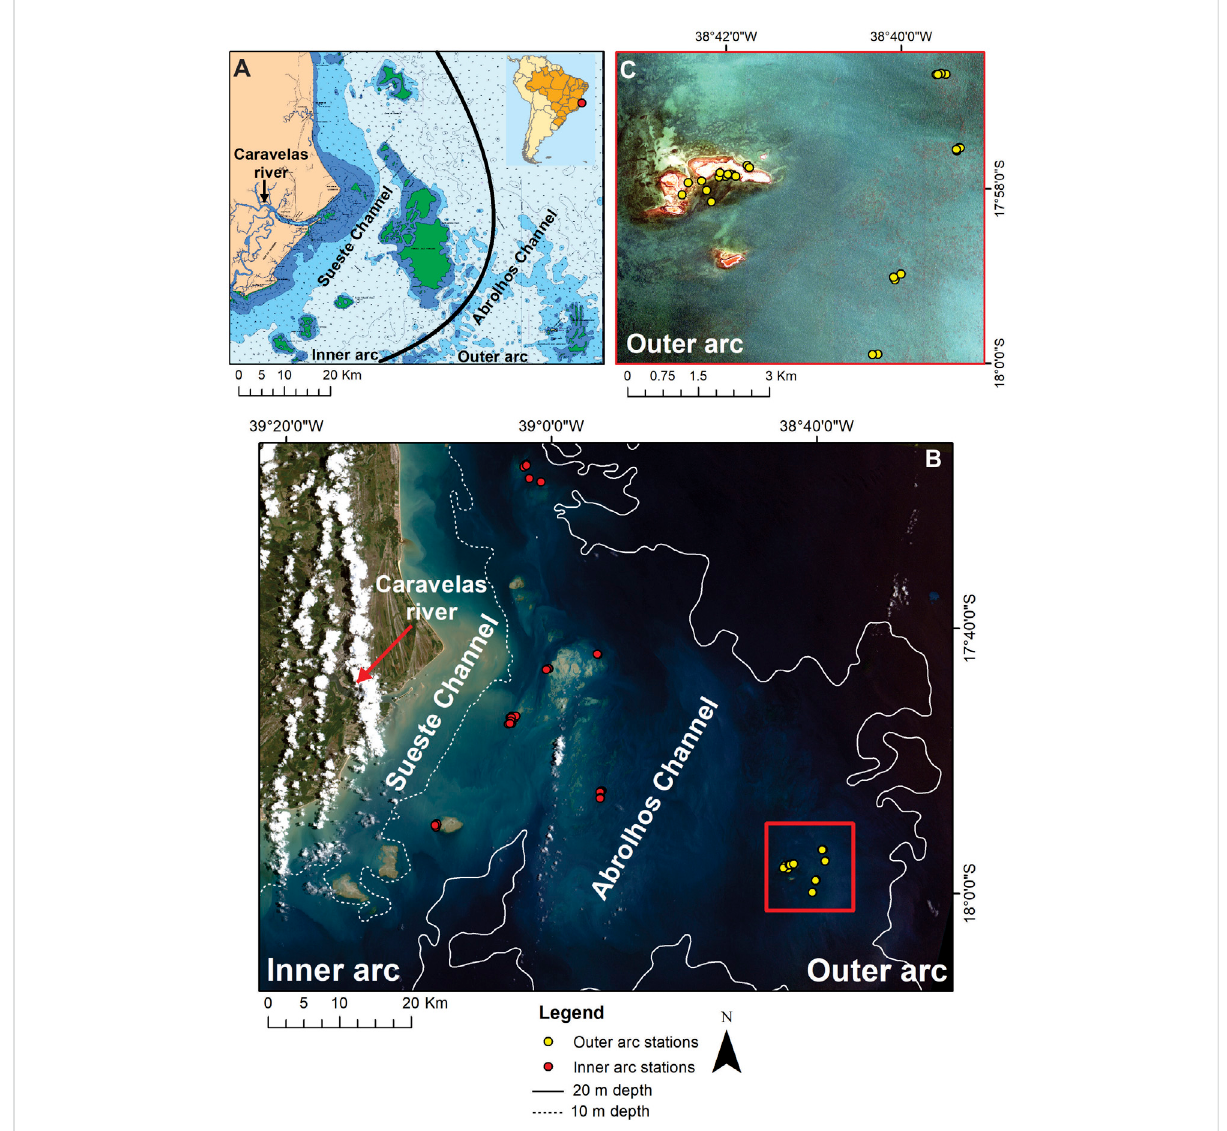
FIGURE 1 Location of the sampling stations in the Abrolhos Bank. (A) General geographical location of the study area, highlighting the Sueste and Abrolhos channels and the inner and outer arcs. Source: adapted from Brazilian Directory of Hydrography and Navigation (DHN), Navigation Chart: 1,310. (B) CBERS-4 image (true color composition) showing the location of the sampling sites in the inner (red dots) and outer (yellow dots) arcs. (C) WorldView-2 image (true color composition) showing the outer arc area and respective sampling points (yellow